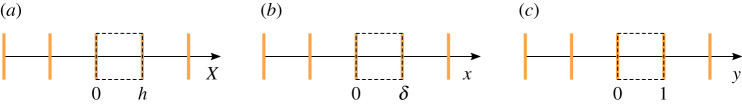
Geometry settings in the (a) X, (b) x and (c) y variables, a periodic cell is highlighted with a dashed line. (Online version in colour.)